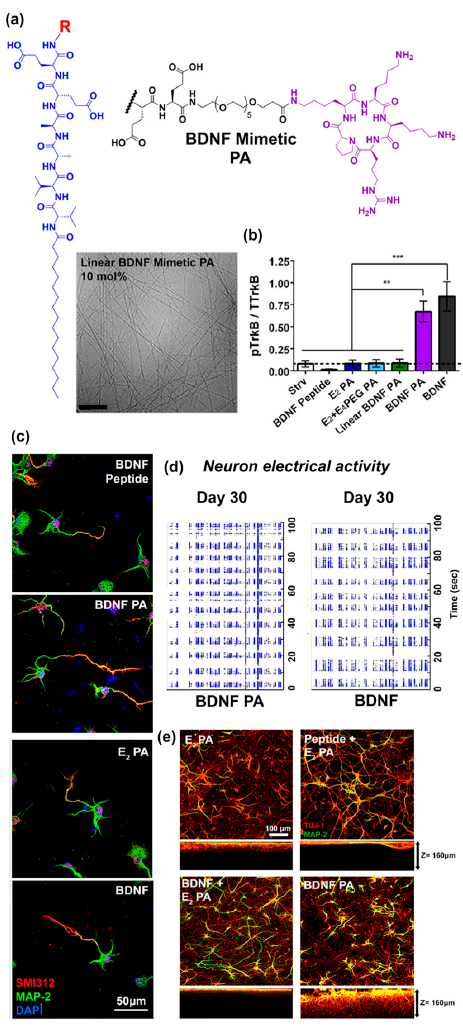
Figure 3. ( a ) Chemical structure of cyclic brain-derived neurotrophic factor (BDNF) mimetic peptide. Representative Cryo-TEM image of nanofibers derived from BDNF peptide amphiphiles (PA) co-assembled at 10 mol.% with E 2 PA. β -sheet fibrous materials were obtained via assembly of BDNF PA and E 2 PA. ( b ) Western blot densitometry analysis of phosphorylated tyrosine kinase B (p-TrkB) activation by cells treated with BDNF peptide, E 2 PA, E 2 + E 4 , linear BDNF, BDNF PA, and BDNF protein for 6 h in vitro. The BDNF PA-treated group showed comparable activation as cells treated with BDNF protein and significantly higher response relative to all other groups. ( c ) Representative confocal images of neuronal cells treated with BDNF peptide, E2 PA, BDNF PA, and BDNF protein for 24 h in vitro. Red fluorescence represents the axonal marker, pan-axonal neurofilament protein (SMI312), expressed on the cell surface, while green fluorescence represents the dendritic marker, microtubule associated protein 2 (MAP-2). The nucleus was stained using 4 (cid:48) ,6-diamidino-2-phenylindole (DAPI) (blue fluorescence). A notable increase in axon length was observed when cells were treated with BDNF PA or BDNF protein, which suggests maturation of neuronal cells activated by TrkB receptor binding. ( d ) Raster plots show enhanced electrical activity for cells treated with BDNF PA or BDNF protein over 30 days of in vitro culture. ( e ) Representative confocal images of neuronal cells cultured on three-dimensional (3D) PA gel sca ff olds for one week in vitro. Green fluorescence represents the dendritic marker MAP-2 on the cell surface, while red fluorescence represents the neuronal marker, neuron-specific class III beta-tubulin (Tuj-1). Extended neurites and a homogeneous neuronal network were observed in all gels tested. Furthermore, significantly higher MAP-2 expression was observed for cells cultured on BDNF PA gels or native BDNF + E 2 PA gels when compared to other groups. ( ∗ ) p < 0.05, ( ∗∗ ) p < 0.01, and ( ∗∗∗ ) p < 0.001. Adapted with permission from [70]. Copyright 2018, American Chemical Society